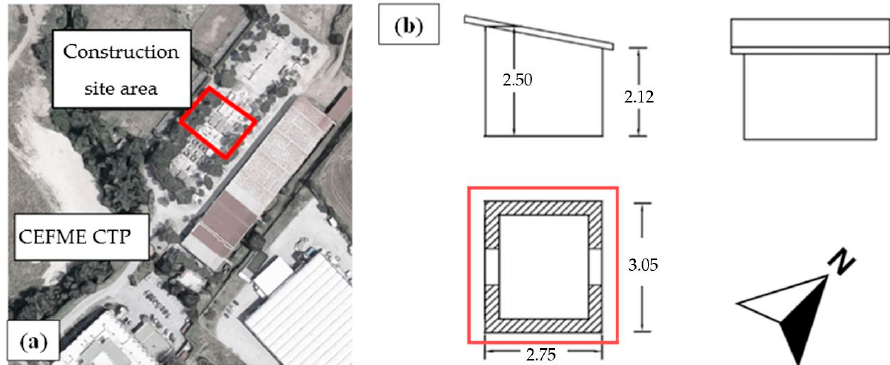
Figure 1. Aerial view of the construction site ( a ), geometrical characteristics of the monitored test rooms ( b ). Table 1. Test Rooms’ Components Stratigraphy.